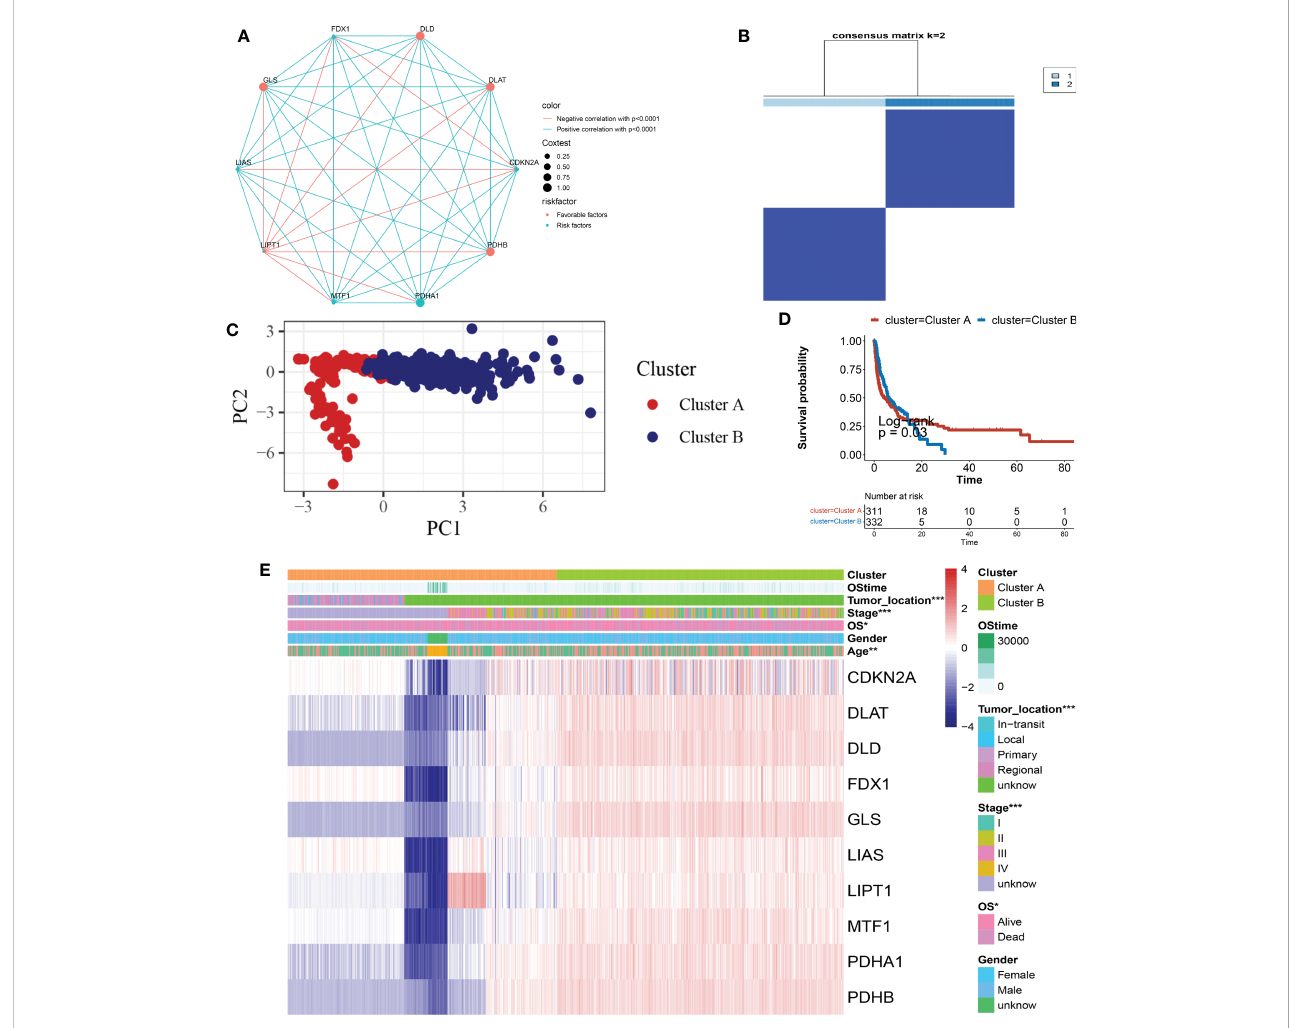
FIGURE 3 CRG subtypes, as well as clinical and pathological, and biological characteristics of 2 different subgroups of samples, were separated by consistent categorization. (A) Interactions between CRGs in SKCM. The interaction between CRGs is represented by the line connecting them, with the thickness of the line indicating the strength of the association between CRGs. Green represents negative correlations, while pink represents positive correlations. (B) Heatmap of the consensus matrix de fi ning two clusters (k = 2) and their correlation area. (C) A PCA analysis reveals a signi fi cant difference in transcriptomes between the subgroups. (D) Univariate analysis of ten CRGs associated with OS time. (E) Clinicopathologic features and CRG expression levels differ between the two distinguishable subgroups. CRG, cuprotosis-related gene; SKCM, Skin Cutaneous Melanoma; PCA, principal components analysis; OS, overall